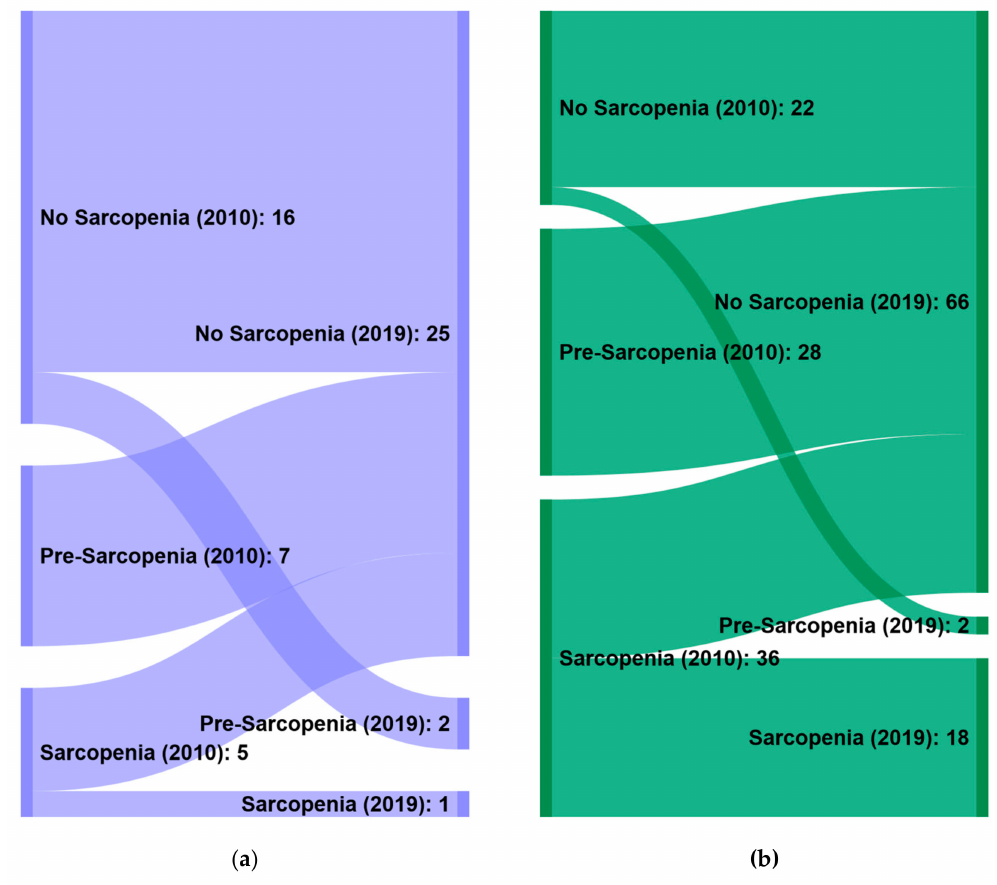
Figure 2. Sankey diagram to visualize and quantify the changes in sarcopenia diagnosis in women ( a ) and men ( b ) using the EWGSOP 2010 and 2019